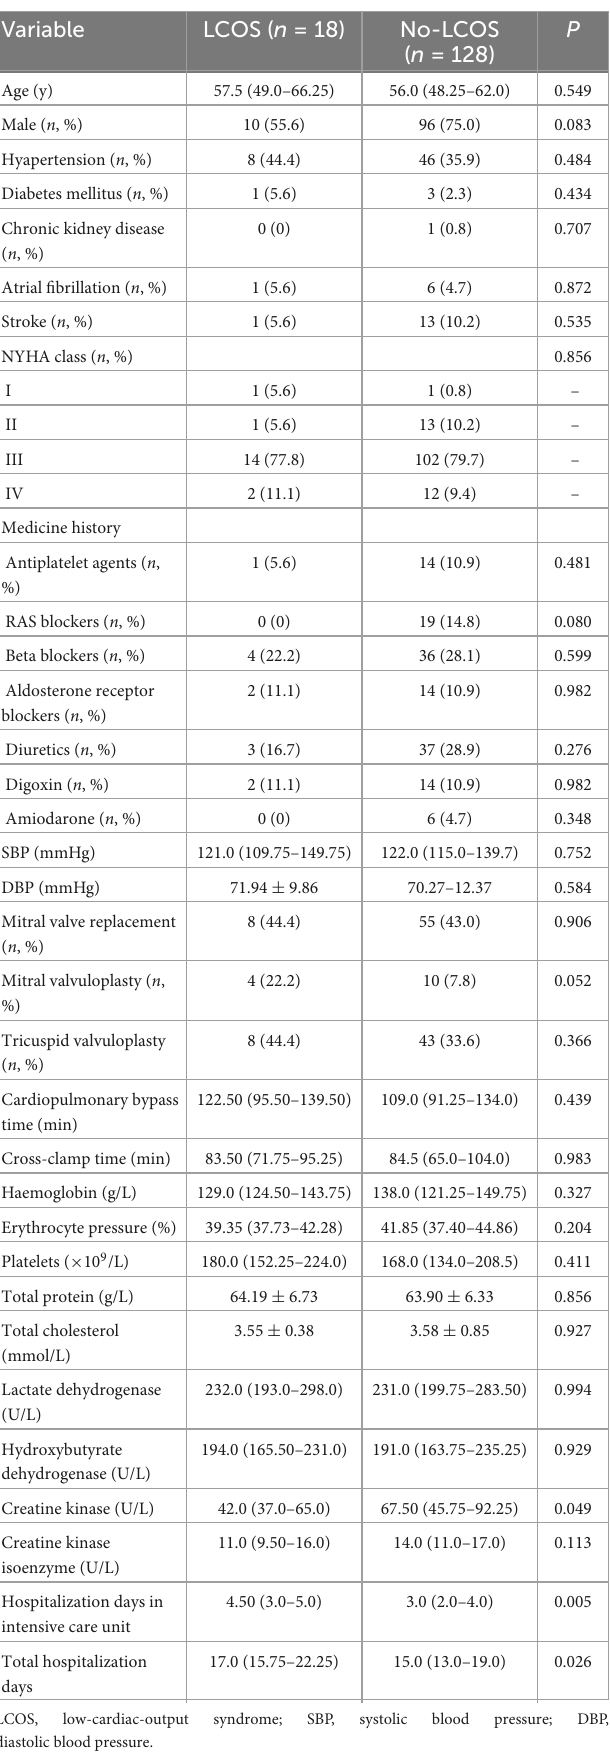
TABLE 1 Baseline characteristics in patients with LCOS.